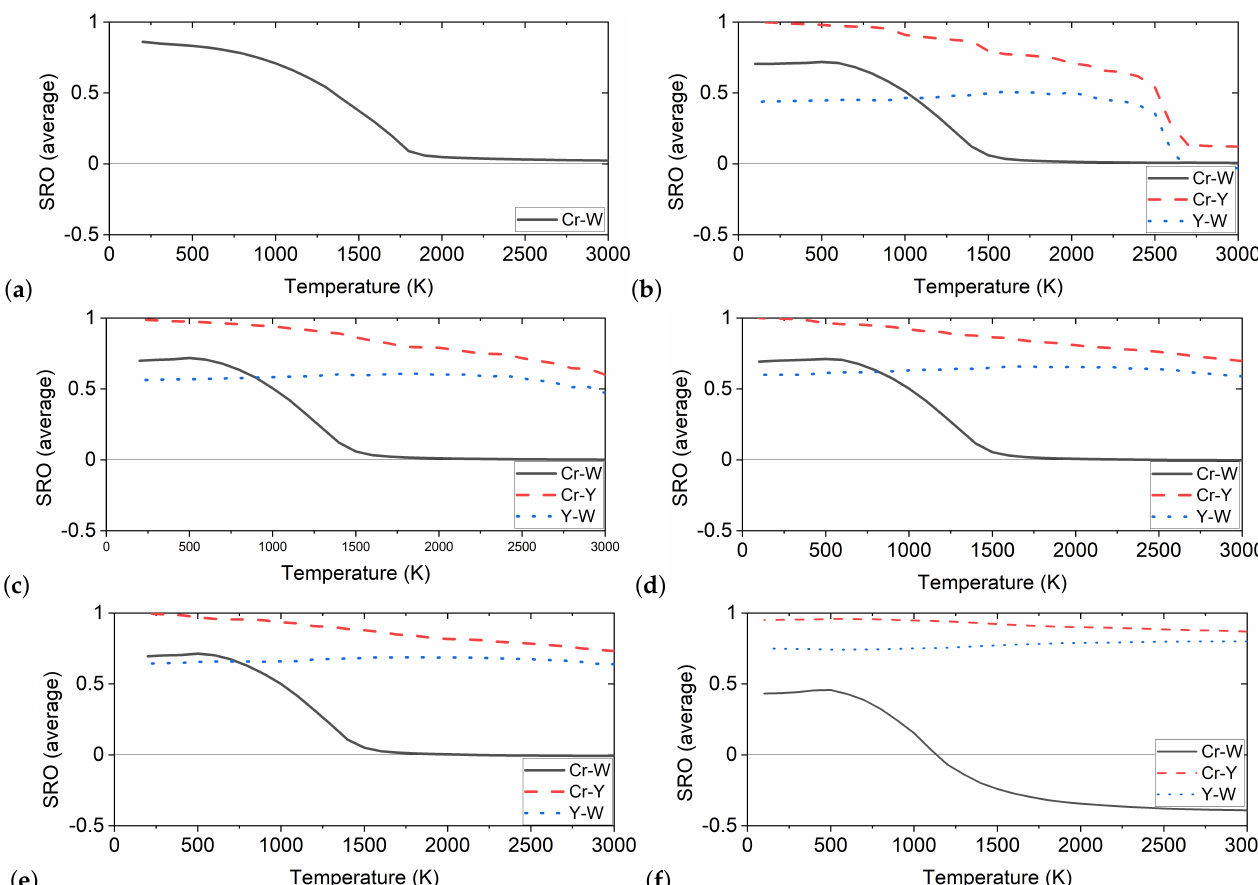
Figure 6. Average short-range order parameters for ternary ( a ) W 70 Cr 30 , ( b ) W 70 Cr 29.5 Y 0.5 , ( c ) W 70 Cr 29 Y 1 , ( d ) W 70 Cr 28.5 Y 1.5 , ( e ) W 70 Cr 28 Y 2 , and ( f ) WCrY